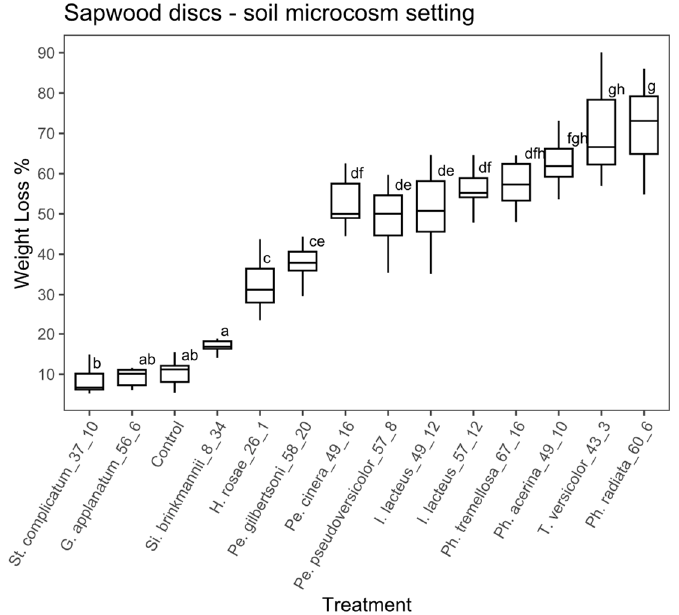
Figure 5. Boxplot of the percentage of weight loss for sapwood discs in the soil microcosm. Different letters represent statistical differences between treatments ( p < 0.01).